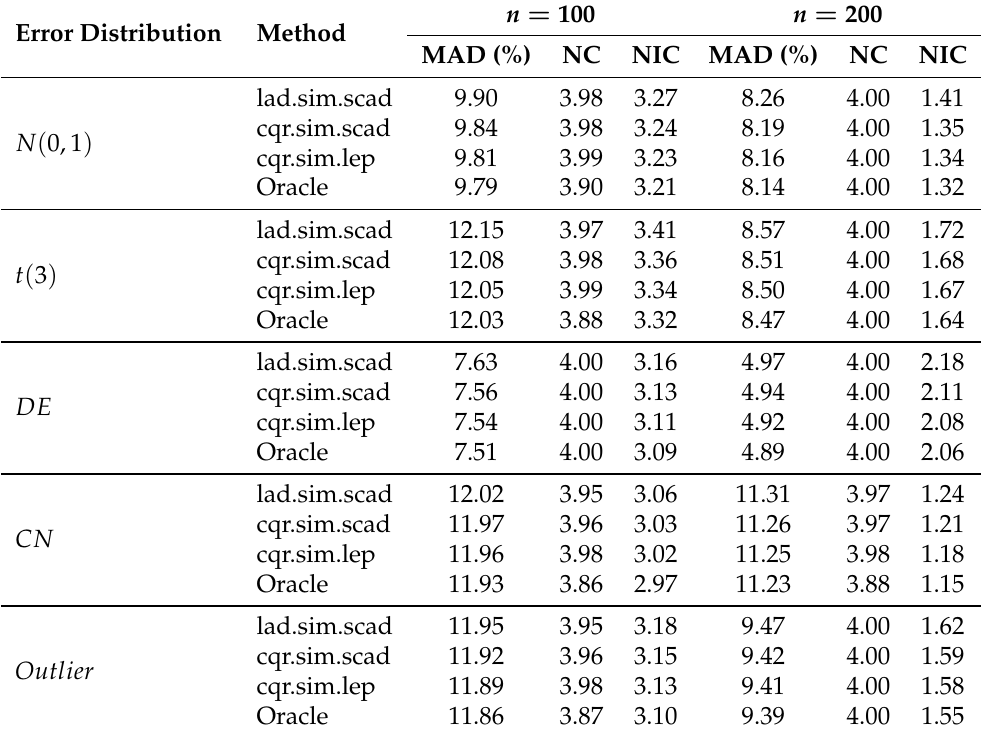
Table 2. Simulation results for Scenario 2 based on 200